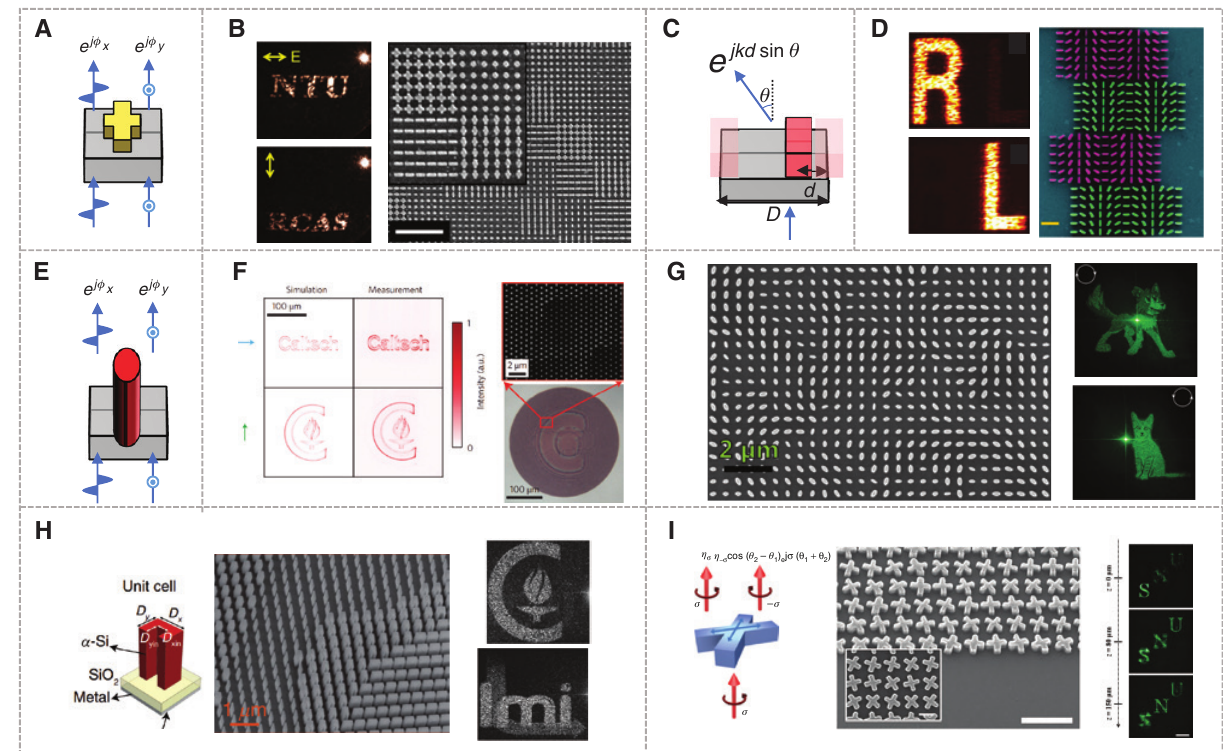
Figure 2: Meta-hologram multiplexing. (A) Schematic diagram of anisotropic resonant plasmonic meta-atom. The light scattered by this meta-atom becomes to get distinctive phase values according to the polarization states of incident light. (B) Polarization-controlled dual holographic images by anisotropic plasmonic metasurface [63]. The left images show the experimental result by polarization, and scanning electron microscope (SEM) images are shown on the right side. Scale bar is 2 μ m. (C) Schematic illustration for the explanation of the detoured phase. As mentioned in the text,